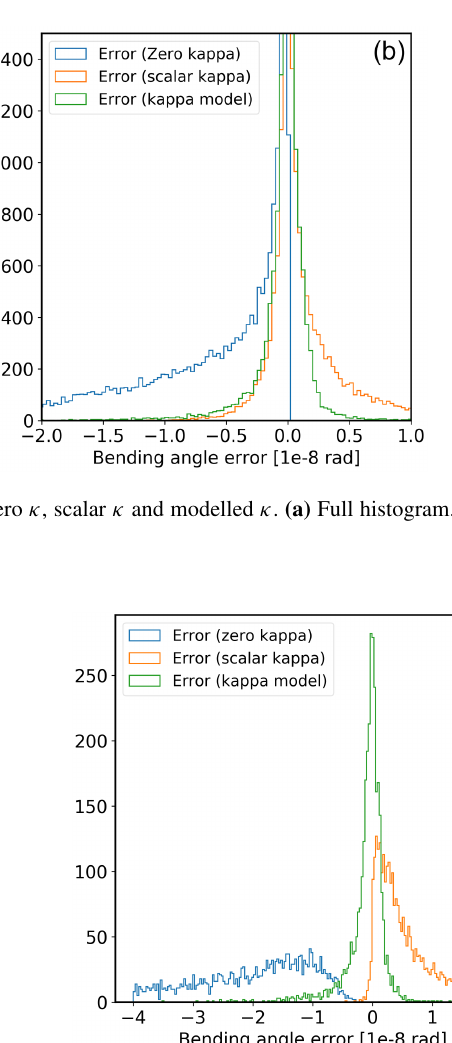
Figure 15. κ model for 12:00UT, F10.7 = 150, June (a) and December (b) . Compare to Fig. 8.